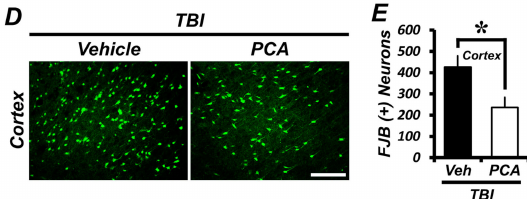
Figure 1. Protocatechuic acid (PCA) reduces the number of degenerating neurons after traumatic brain injury (TBI). Neuronal death was examined by Fluoro-Jade B (FJB) staining. Thus, FJB positive neurons were not detected in the sham-operated groups. ( A ) A schematic drawing indicates quantified area in the hippocampus and cerebral cortex. ( B , D ) Fluorescence images represent the relative degree of neuronal death in the hippocampus ( B ) and cortex ( D ) at 24 h after TBI. PCA administration reduced the number of FJB (+) neurons in the hippocampus and cortex when compared to the vehicle-treated group. Scale bar = 100 µ m. ( C , E ) The bar graph shows the number of degenerating neurons in the hippocampus ( C ) and cortex ( E ). Data are mean ± SEM, and n = 10 from each TBI group. * Significantly different from vehicle-treated group, p < 0.05. Veh = Vehicle; SR = Stratum Radiatum; PL = Pyramidal Layer; SO = Stratum Oriens of hippocampus cornu ammonis 1 (CA1) and CA3